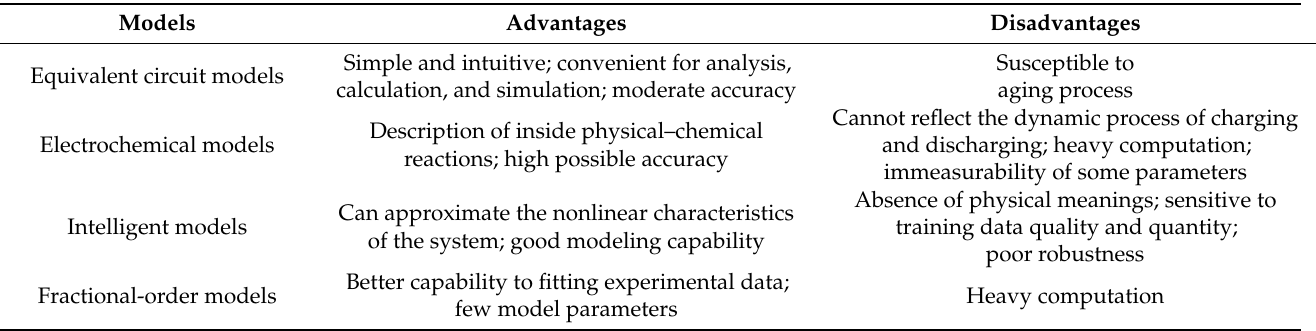
Table 1. Summary of model types for SC electrical behavior simulation.